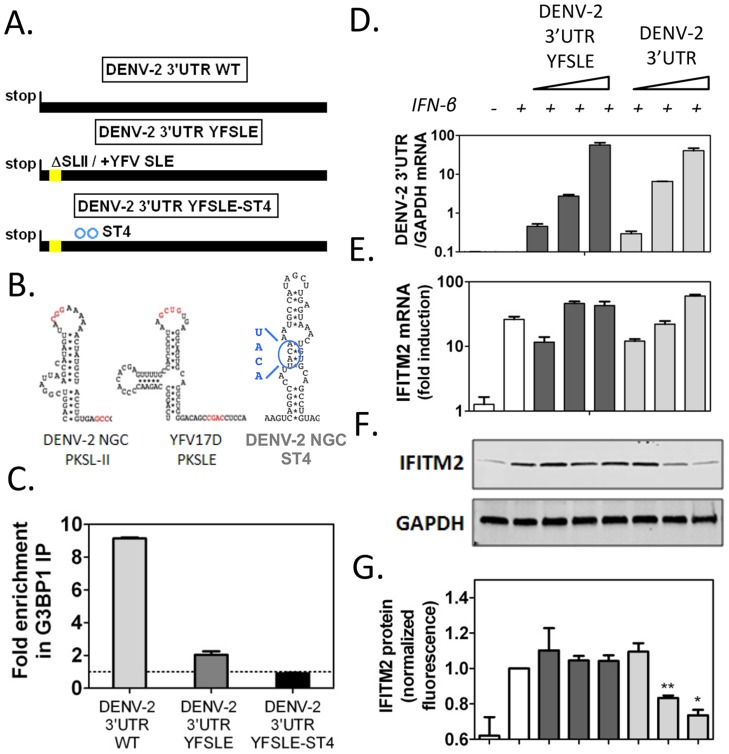
DENV-2 3′UTR downregulates ISG protein expression through G3BP1, G3BP2 and CAPRIN1 binding.(A) Schematics of DENV-2 3′UTR RNAs synthesized to mimic sfRNAs: DENV-2 3′UTR WT, DENV-2 3′UTR YFSLE replaced SL-II/PKSLII with the equivalent structure in YFV-17D (YFV-17D SLE, see panel B) in the DENV-2 3′UTR background, and DENV-2 3′UTR YFSLE-ST4 which contains an additional four point mutations in the middle stem of SL-IV. The corresponding structures are shown in (B). Nucleotides implicated in pseudoknot formation are highlighted in red and substitutions in DENV-2 SL-IV in blue. (C) In vitro transcribed DENV-2 3′UTR RNAs were transfected into HuH-7 cells and their binding to G3BP1 was interrogated by G3BP1 IP. Results are presented as mean ± SEM of three independent experiments, normalized to control IgG IP. (D–G) HuH-7 cells were transfected with 5 ng, 50 ng or 500 ng of in vitro transcribed DENV-2 3′UTR or DENV-2 3′UTR YFSLE, and treated with 100 UI/ml IFN-β for 4 h. (D–E) Levels of viral 3′UTR and IFITM2 RNAs were measured by quantitative real-time PCR and normalized to intracellular GAPDH mRNA levels. (F–G) Levels of IFITM2 protein were determined by western blots and quantified by analysis of fluorescence intensity relative to GAPDH. All results are presented as mean ± SEM of three independent experiments in triplicate. One representative western blot used for IFITM2 protein quantification is shown.